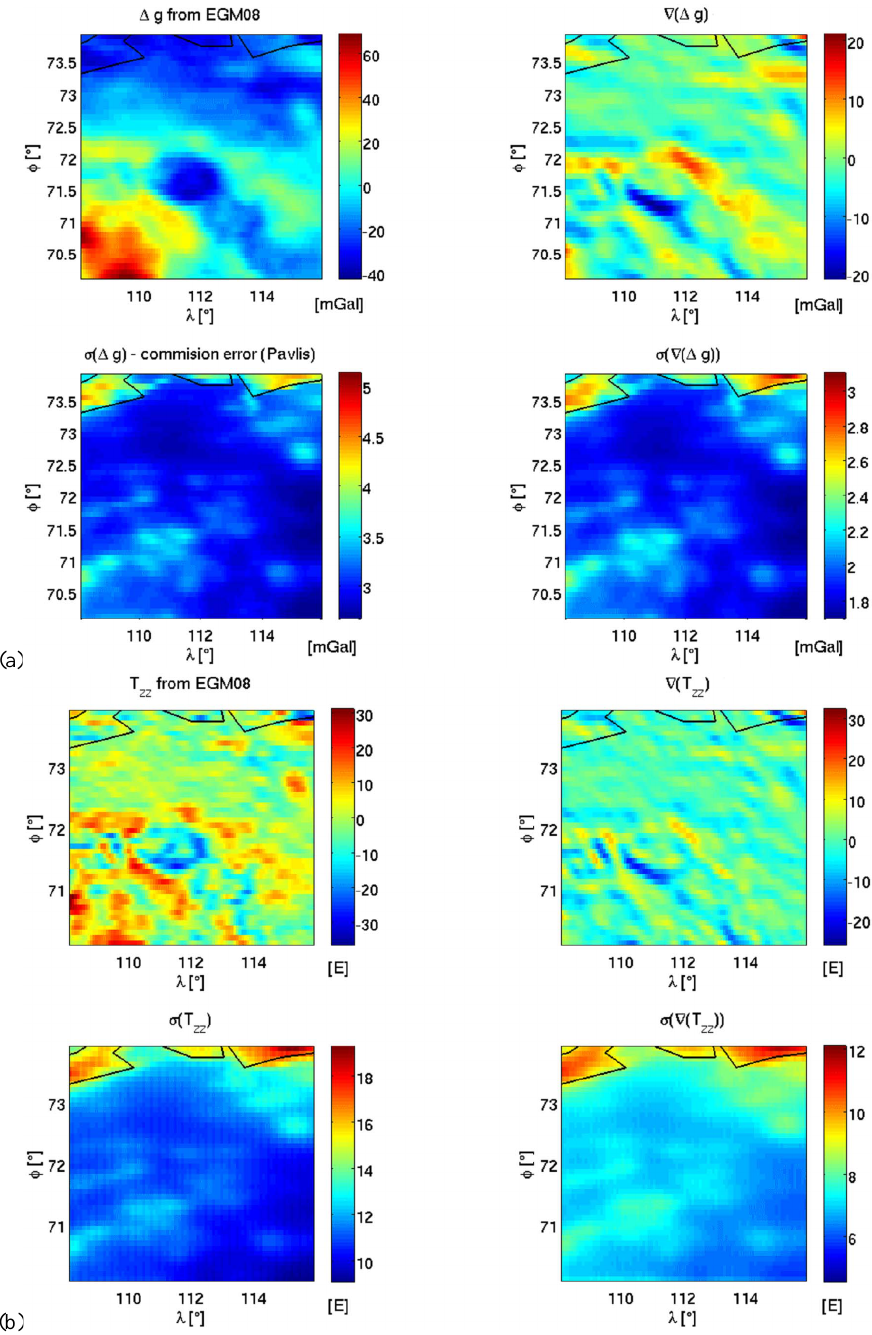
Fig. 9. (a) : Comparison of the gravity anomaly 1g (upper left) and its gradient (upper right) with relevant σ (1g) (lower left) and σ( grad (1g)) (lower right) for Popigai. (b) : Comparison of the second radial derivative T rr (upper left) and its gradient (upper right) with relevant σ (T rr ) (lower left)and σ ( grad (T rr )) (lower right) for Popigai. for Ries and Steinheim is large. The former can be detected as a double crater by EGM2008, the latter